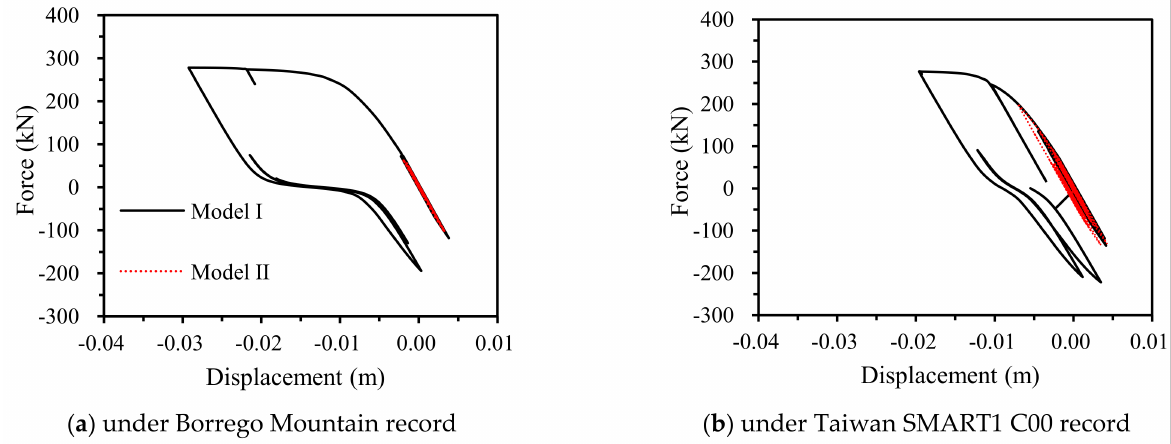
Figure 15. Force-displacement relation of p - y springs around pile